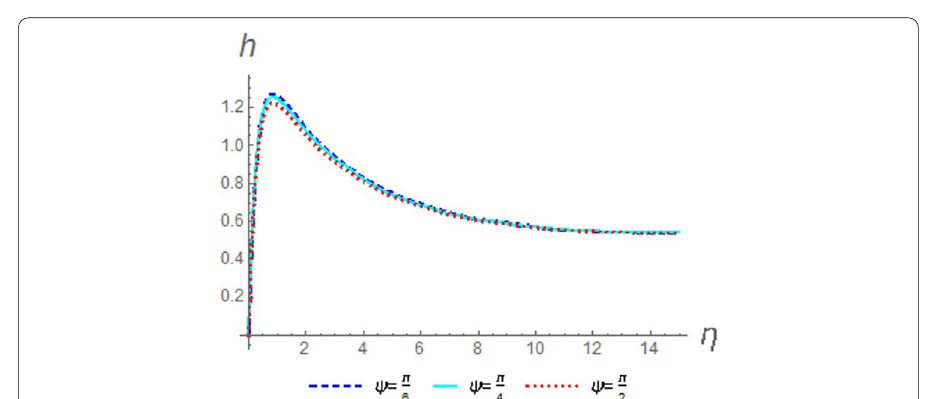
Fig. 4 Effect of ψ on the velocity